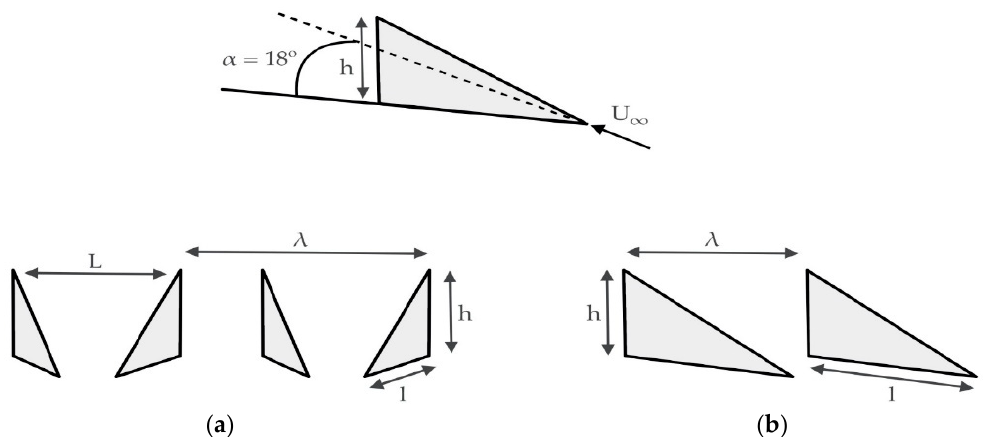
Figure 1. Schemes of two main configurations. ( a ) Counter rotating VGs Configuration and ( b ) Co-rotating VGs Configurations of Vortex Generators.